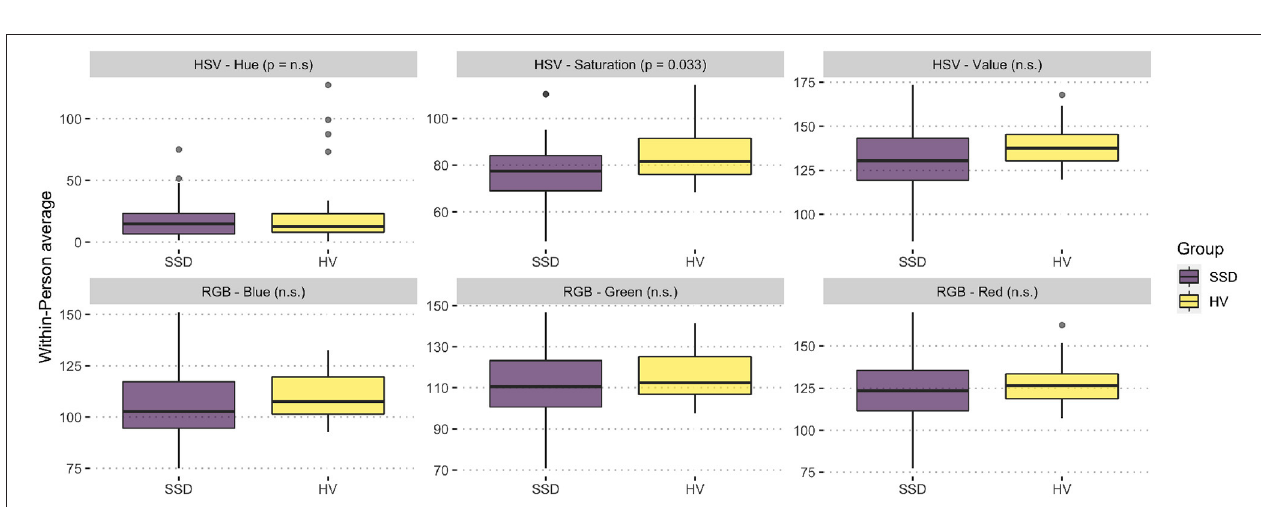
FIGURE 2 | Overview of HSV and RGB color distribution in image posts. Pairwise Comparison of the color components of the HSV and RGB color spaces. Results show significantly higher average saturation in HV compared to SSD, but no significant (n.s.) differences in all other color components.